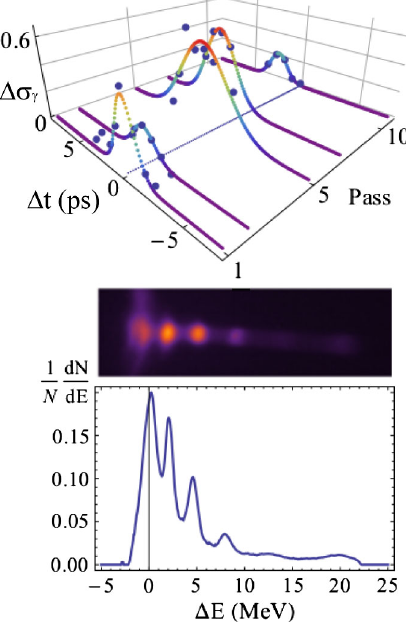
FIG. 5. (top) IFEL-induced rms energy modulation on the injected bunch ( σ γ ) when varying the external delay stage at 1st, 2nd, 5th, 7th and 12th pass, showing a 2 ps drift of the optimal timing over 12 passes. (bottom) Maximized IFEL energy modu- lation at the 5th pass, showing a 6% fraction of the initial beam accelerated to the final IFEL ouput